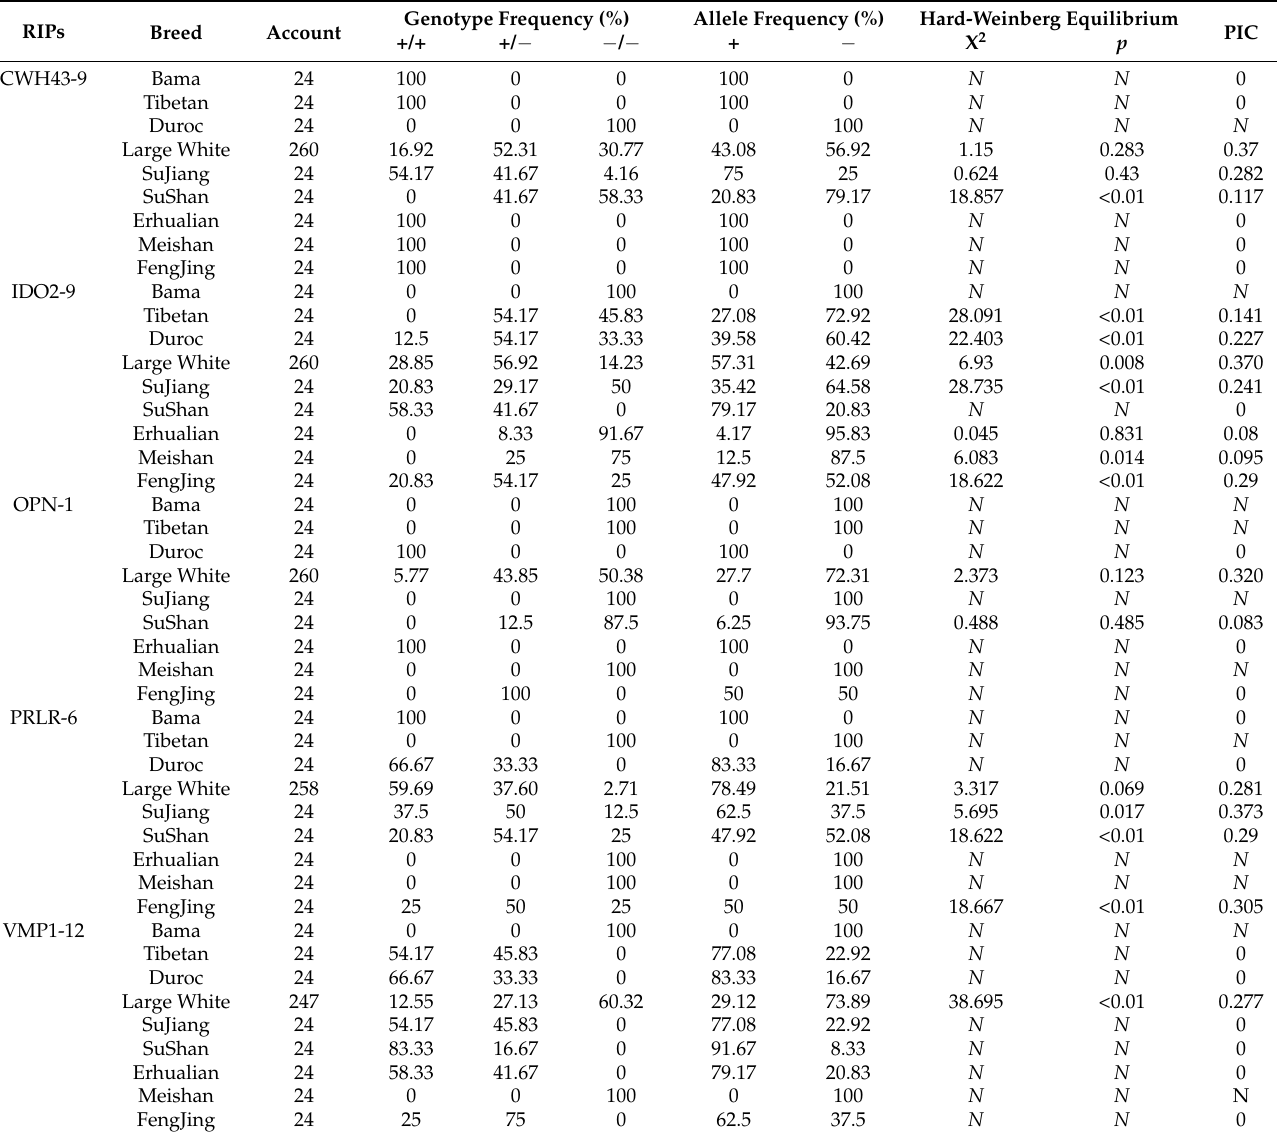
Table 3. The analysis of the genetic diversity of SINE-RIPs in different